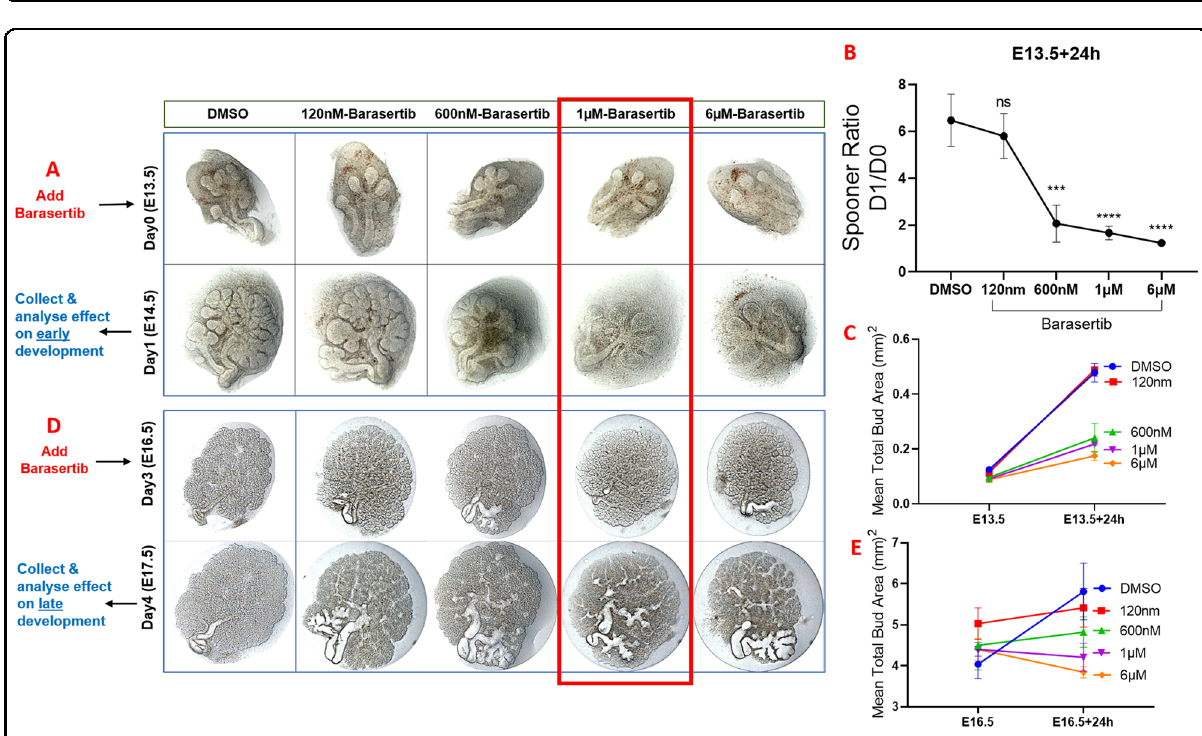
Fig. 1 Anatomic location & histomorphology of the embryonic submandibular glands. A Low magni fi cation image of E14.5 mouse head (frontal view) stained with H&E and showing the anatomical position of the submandibular glands (SMG) (red dotted outline) beneath the tongue, scale bar = 100 µm. Area outlined with blue square in ( A ) is stained with AURKB in ( B ), scale bar = 20 µm. C – E High magni fi cation images showing abundant immunolabelling of nuclei with AURKB (brown) in the mouse SMGs throughout development. AURKB was mainly expressed in the bud nuclei, in addition to sporadic cytoplasmic immunostaining, scale bar = 10 µm.